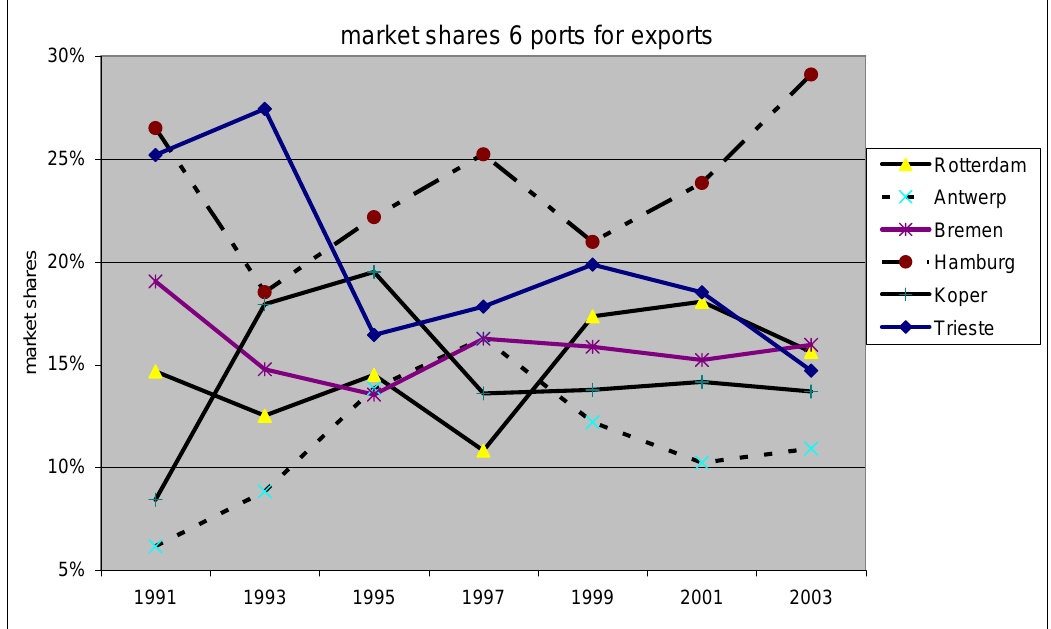
Figure 4. Market shares of ports for Austrian exports